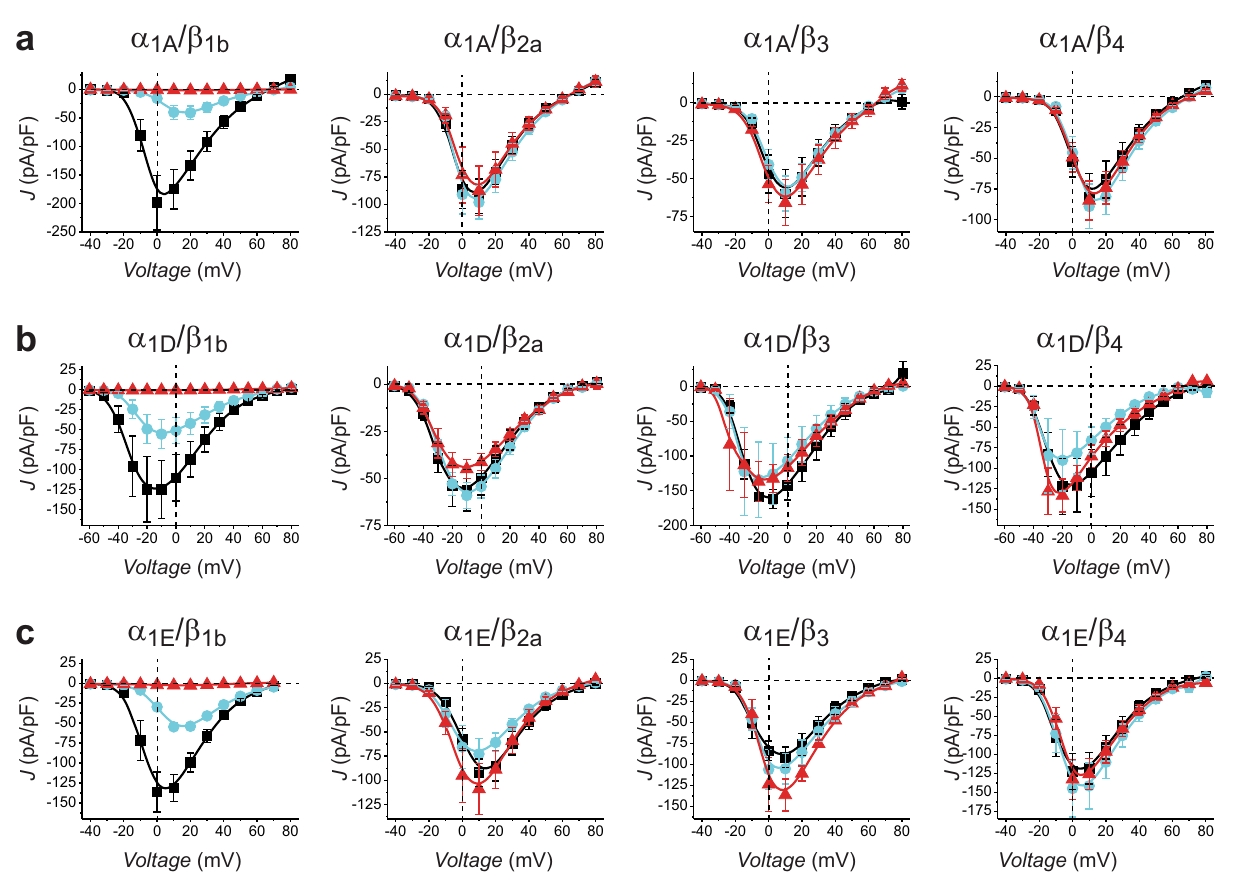
α β α δ − 1 (CFP, n =8; nb.E8, n =9, Chisel-1, n =5); α 1D + 1b + 2 nb.E8, n =8, Chisel-1, n =7); α 1D + β 3 + α 2 δ − 1 (CFP, n =3; nb.E8, n =5, Chisel-1, n =5); β α δ − 1 (CFP, n =7; nb.E8, n =10, Chisel-1, n =4). c J-V relationship for cells α 1D + 4 + 2 expressing α 1E + β + α 2 δ − 1withCFP(blacksymbols),nb.E8(cyansymbols)orChisel-1 (red symbols): α 1E + β 1b + α 2 δ − 1 (CFP, n =6; nb.E8, n =8, Chisel-1, n =6); α 1E + β 2b + α 2 δ − 1 (CFP, n =7; nb.E8, n =5, Chisel-1, n =5); α Chisel-1, n =4); α 1E + β 4 + α 2 δ − 1 (CFP, n =12; nb.E8, n =5, Chisel-1, n =6). Data are means±SEM. Source data are provided as a Source Data fi